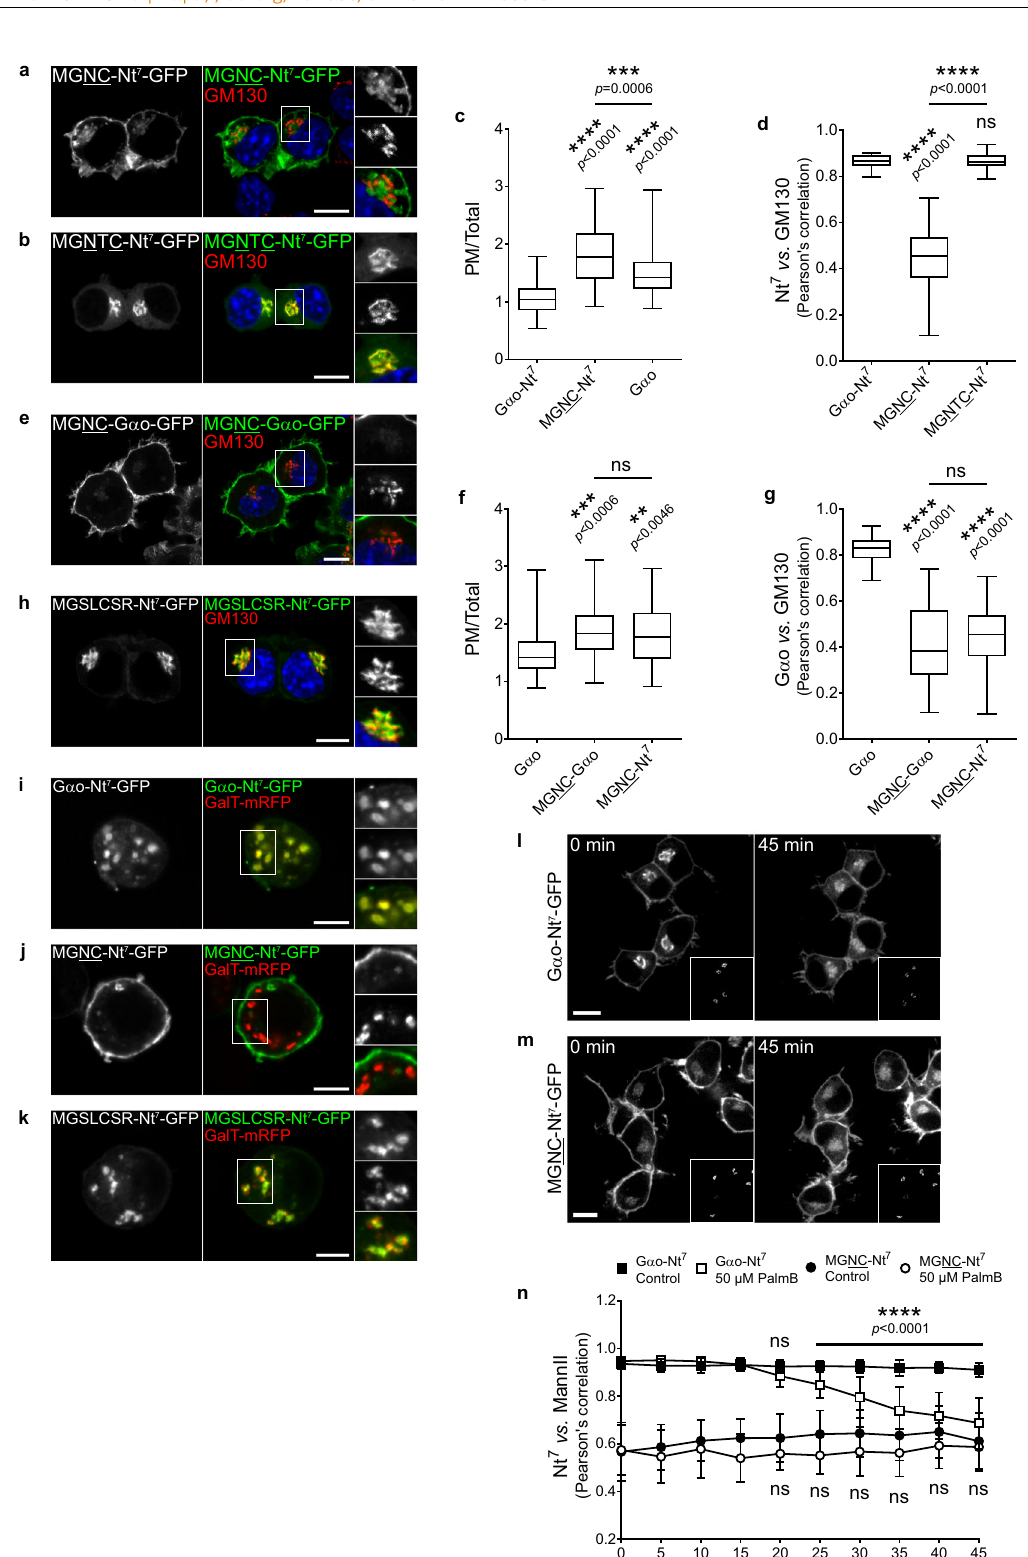
Accordingly, metabolic labeling showed a wild-type-like [ 3 H] palmitate incorporation for MGNC-Nt 7 and only the residual signal for MGNTC-Nt 7 (Supplementary Fig. 1m). S-palmitoylation of MGNC-Nt 7 was additionally con fi rmed by its sensitivity to the inhibitor 2-BrPal (Fig. 1o, p and Supple- mentary Fig.